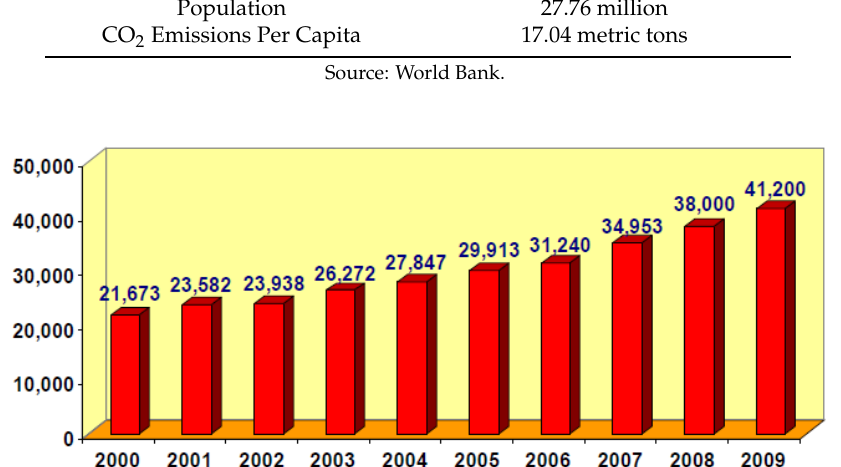
Figure 3. Total peak demand of electricity in the Kingdom (MW).